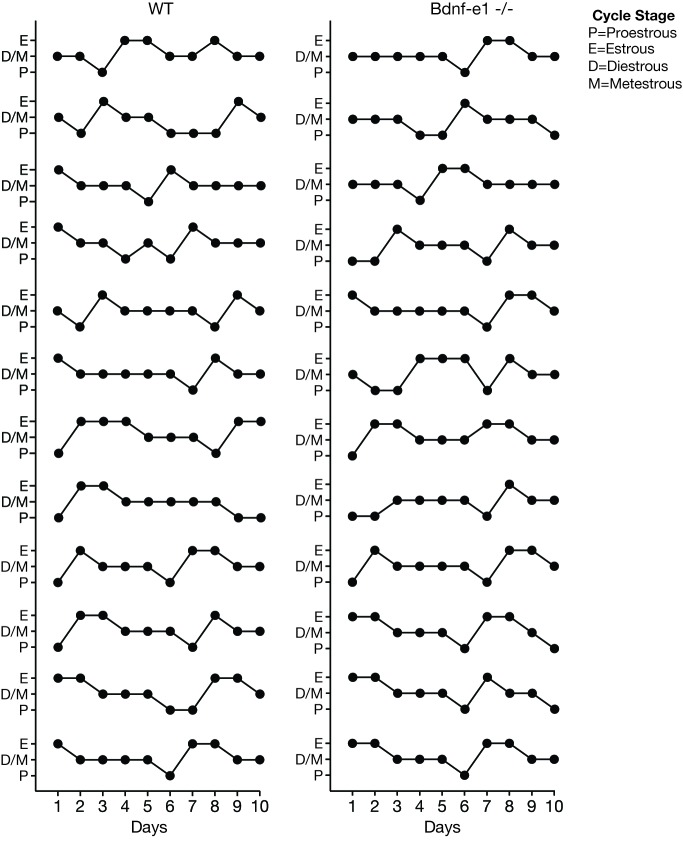
Bdnf-e1 -/- females have a normal estrous cycle.Bdnf-e1 -/- virgin females enter all stages of the estrous cycle, including proestrous (P), estrous (E), diestrous (D), and metestrous (M), similar to WT females. Bdnf-e1 -/- virgins enter estrous ~every 5 days and remain in estrous for 24 – 48 hr.